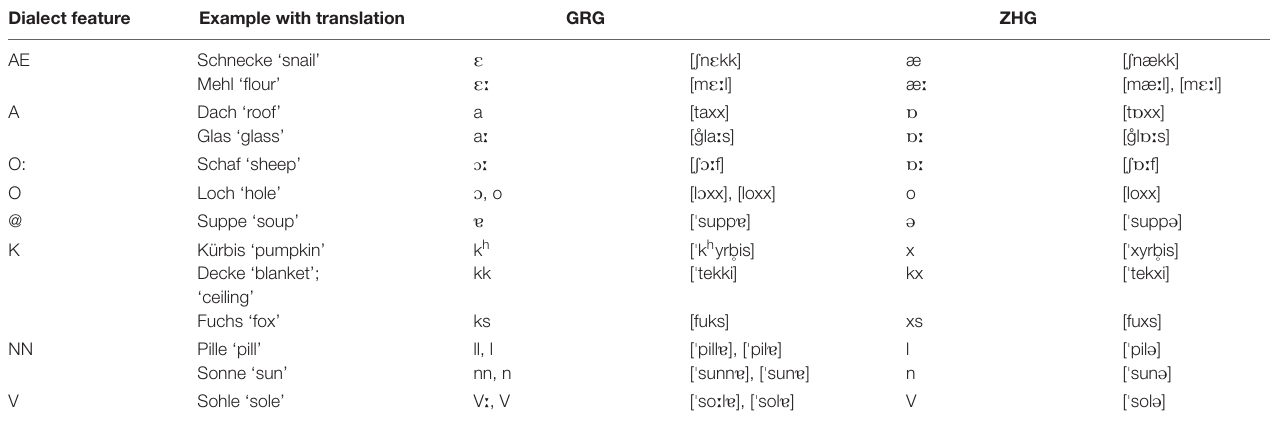
TABLE 1 | Main segmental differences between Grison and Zurich German according to Hotzenköcherle et al. (1962), Fleischer and Schmid (2006), Ruch (2015), and Eckhardt (2016). Dialect